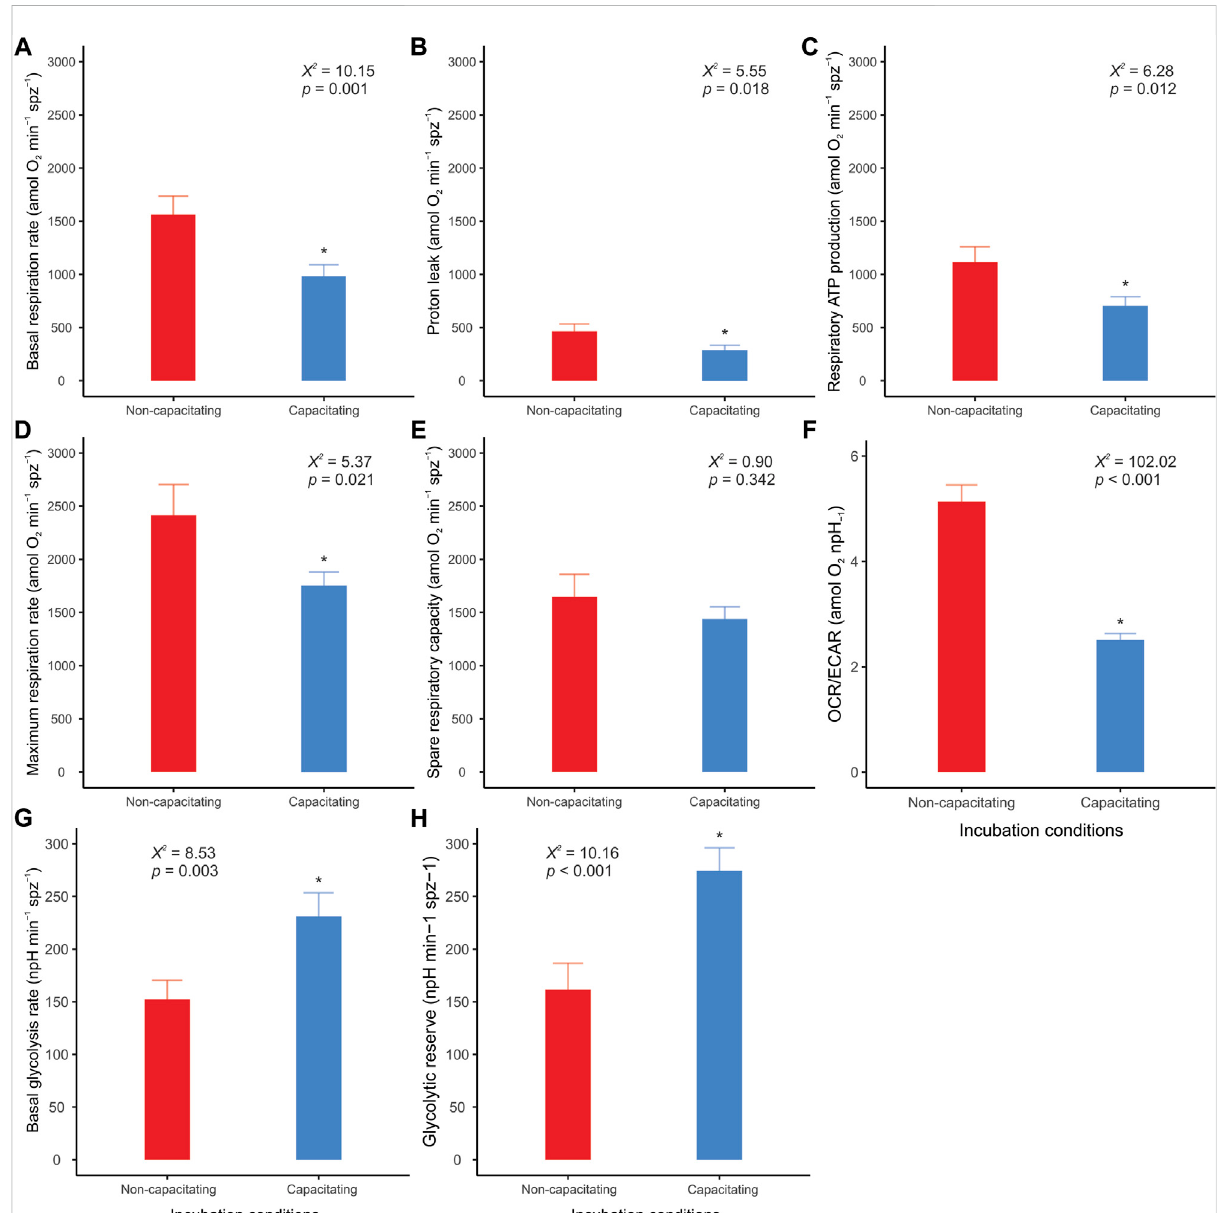
FIGURE 5 Effect of incubation conditions on mouse sperm metabolic parameters and OCR/ECAR ratio. Sperm were incubated in non-capacitating (red bars) and capacitating (blue bars) conditions prior to extracellular fl ux analysis. (A) Basal respiration rate; (B) Proton leak; (C) Respiratory ATP production;(D)Maximum respirationrate;(E)Sparerespiratorycapacity; (F)OCR/ECARratioofbasal state (beforeanyadditions);(G) Basalglycolysis rate; (H) Glycolytic reserve. Bars correspond to means + standard error. Asterisks indicate signi fi cant differences ( p < 0.05) between sperm incubated in non-capacitating and capacitating conditions. X 2 and p values were estimated using LMMs and likelihood ratio